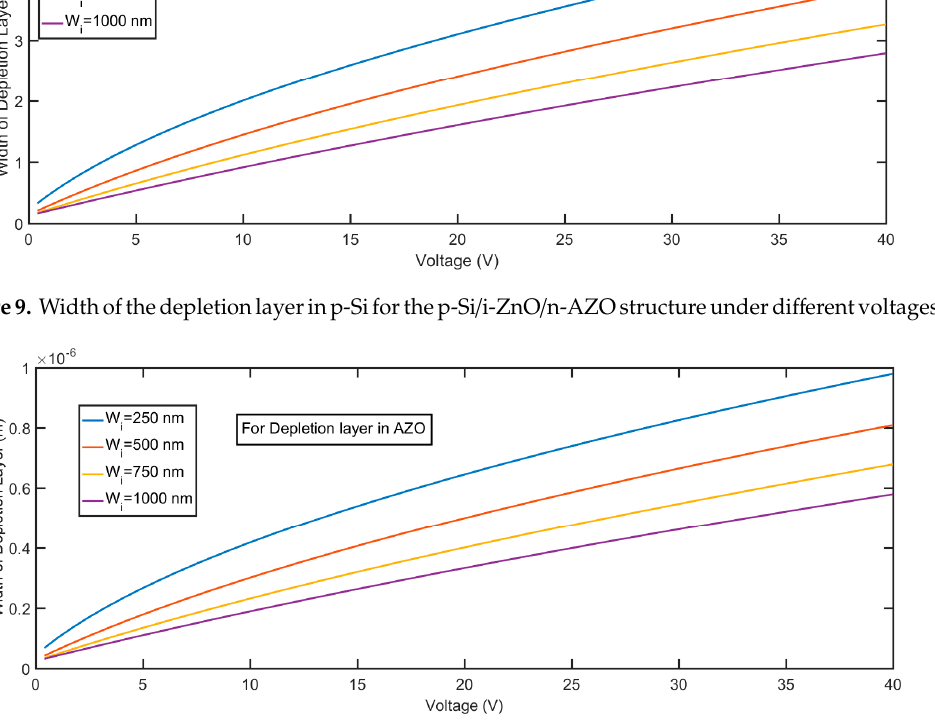
Figure 10. Width of the depletion layer in n-AZO for the p-Si/i-ZnO/n-AZO structure under different voltages. di ff erent